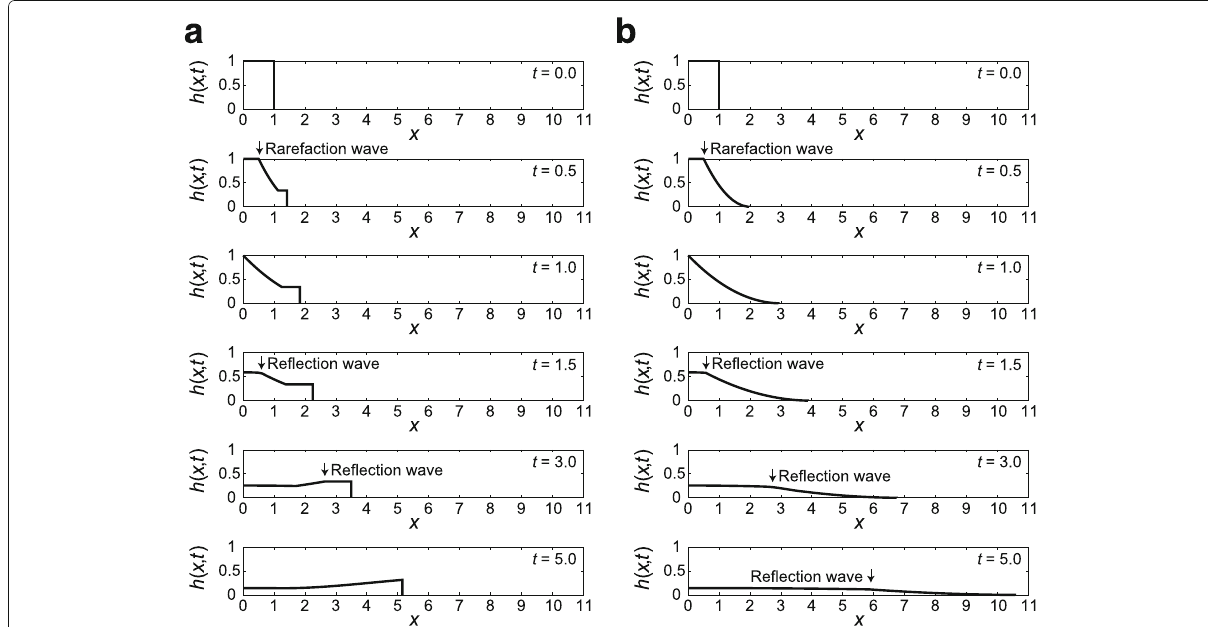
√ 2 (Benjamin 1968) is used. a ρ c /ρ a = 1.01. b ρ c /ρ a = 1000. In ( a ), the Fig. 2 Analytical solutions of h ( x , t ) for the dam-break problem. Here, Fr = currents at t = 0.5, 1.0, 1.5, and 3.0 are in the slumping stage, and the current at t = 5.0 is in the self-similar stage. The initial backward-propagating rarefaction wave arising from the rapidly removed dam travels toward the back wall x = 0 (see the profile at t = 0.5), reaching the wall at t = 1.0. Then, a wave arises from the reflection of the rarefaction wave and travels toward the front (see the profiles at t = 1.5 and 3.0). After the front is caught by this reflection wave, the current is in the self-similar stage (see the profile at t = 5.0). In ( b ), all the currents are in the slumping stage. In this case (i.e., ρ c /ρ a = 1000), the slumping stage continues until t ∼ 226 (see Hogg 2006 for